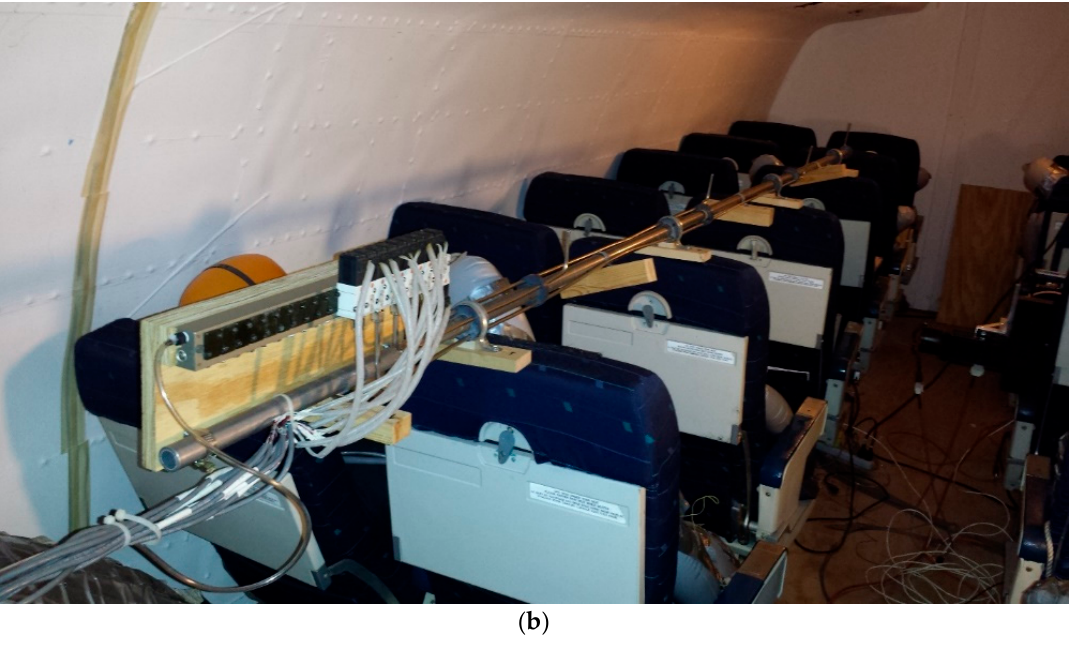
Figure 2. ( a ) tracer gas release tube; ( b ) tracer gas sampling tree.